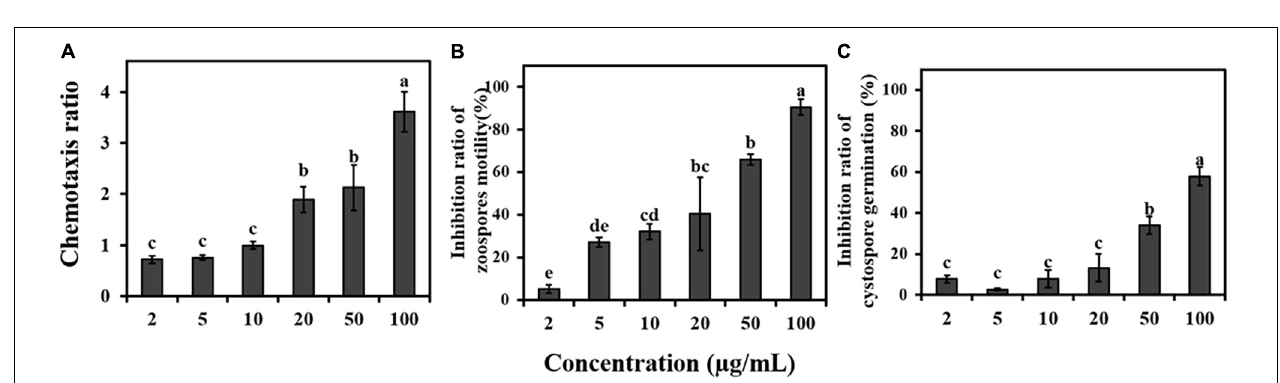
FIGURE 2 | Effects of fennel roots on zoospore behavior of P. capsici. (A,B) Dynamic process of P. capsica zoospore attraction by fennel roots. (C) Cystospore germination. (D) Chemotaxis ratios (CR): fennel root showed significant attraction to zoospores. (E) Germination rate and motility rate in fennel root and zoospore interactions. CK was a capillary tube replacing the root as the control. Significant differences were based on Chi square test ( p < 0.05). The error bars indicate the standard error of the means ( n = 3). *Indicates significant differences between the control and plant root treatment at the 0.05 level.